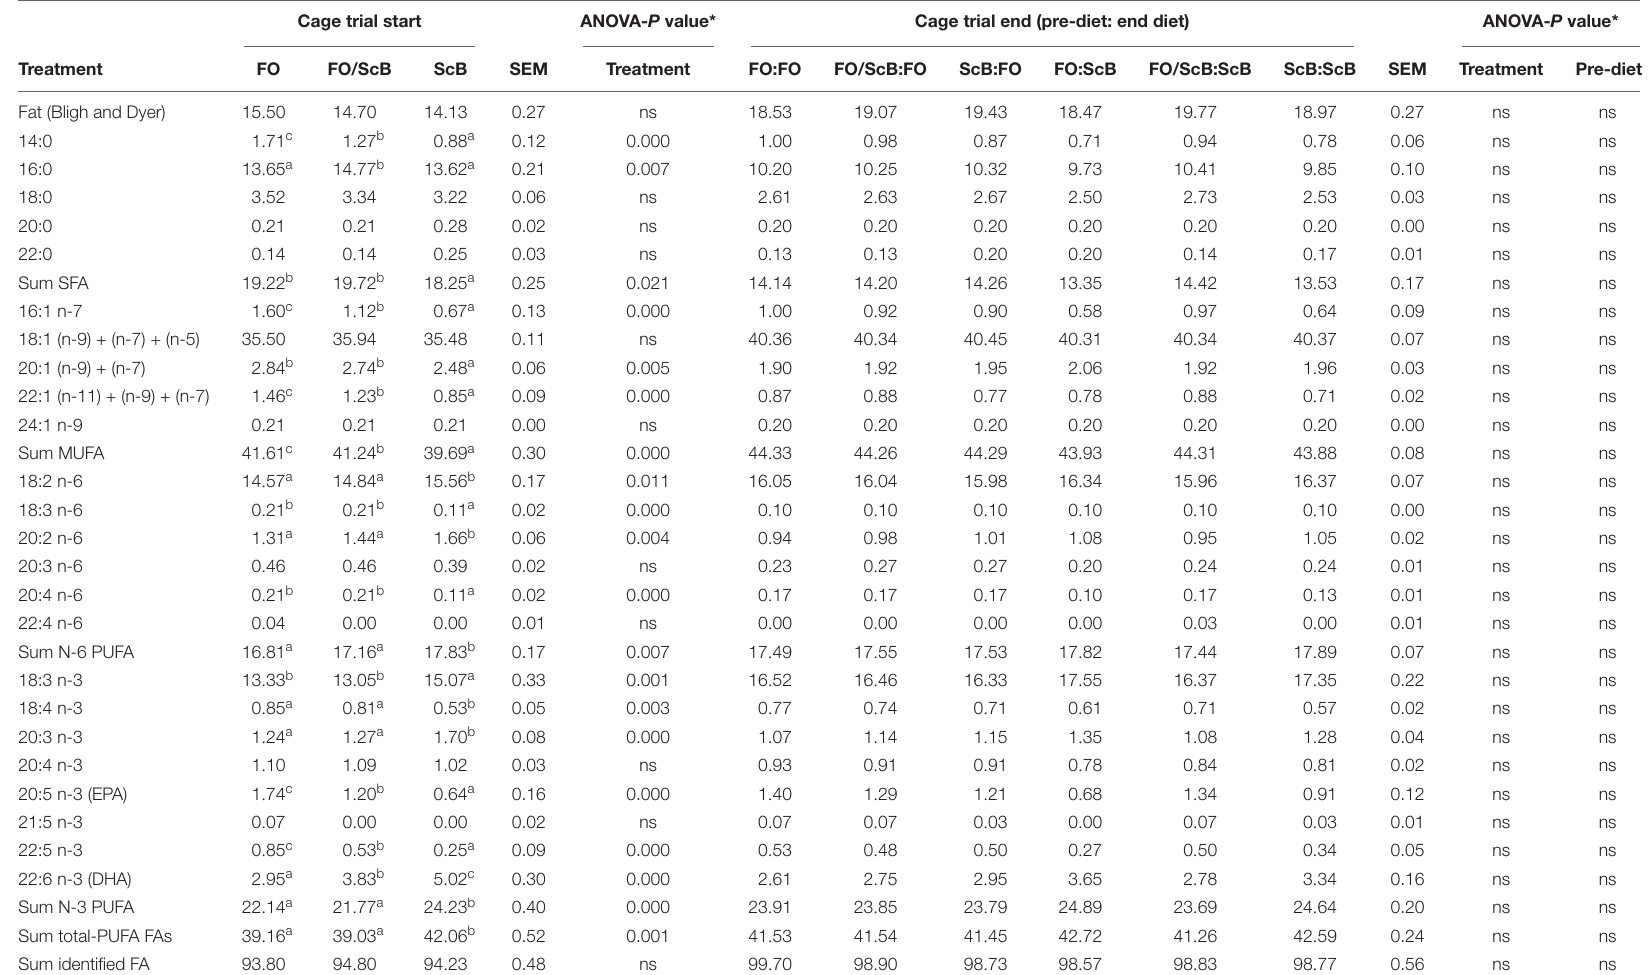
TABLE 7 | Fish whole body fat (%), identified fatty acids (% of fat), and fatty acid composition (% of identified fatty acids) in salmon at start and end of cage trial period fed either ScB or FO diets. Cage trial start ANOVA- P value* Cage trial end (pre-diet: end diet) ANOVA- P value* Treatment FO FO/ScB ScB SEM